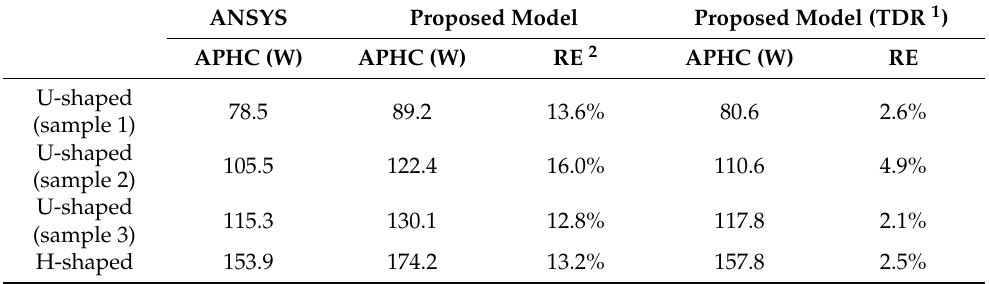
Table 5. APHCs of the corrugated